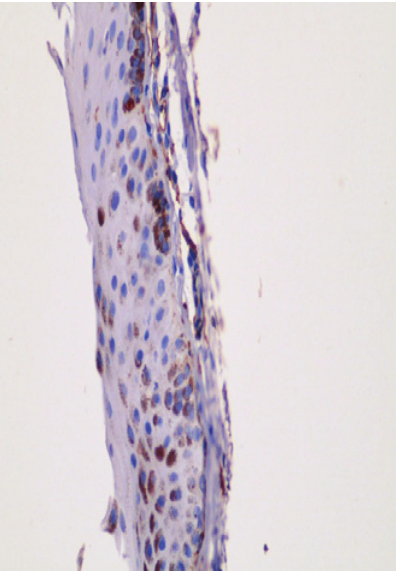
FIGURE 1 - Conjunctival biopsy showing positive labeling for the anti- HLA-DR antibody (arrow). Magnification